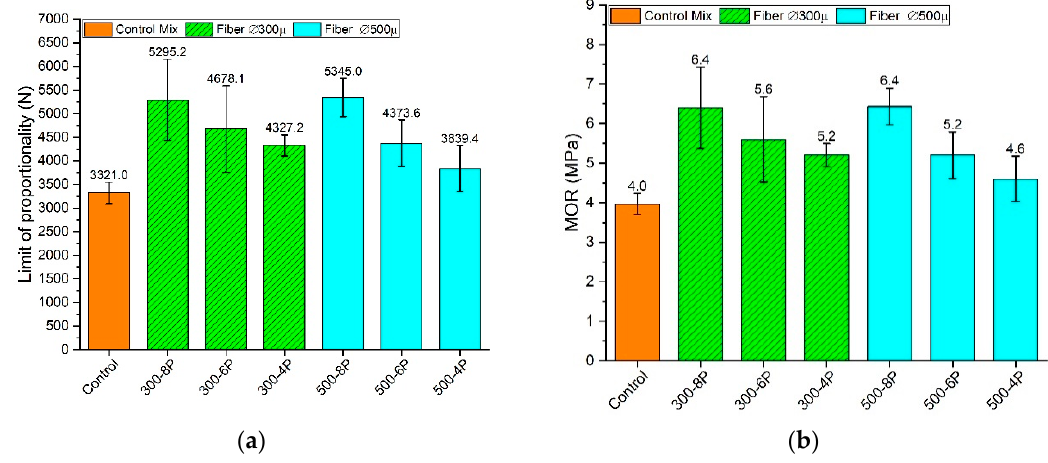
Figure 8. Bending test assessment: ( a ) limit of proportionality F max ; ( b ) modulus of rupture.